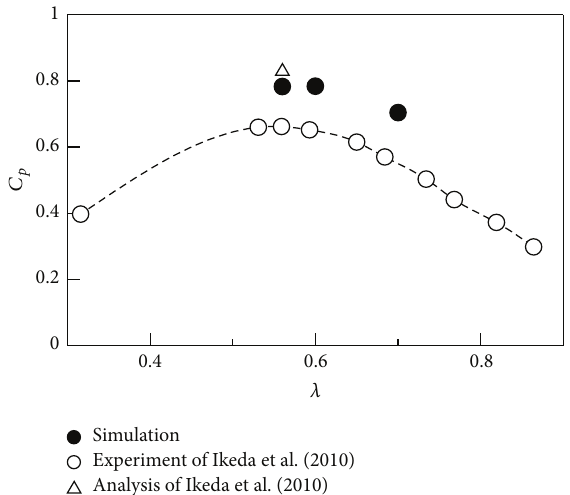
Figure 11: Relation between power coefficient 𝐶 𝑝 and tip speed ratio 𝜆 .